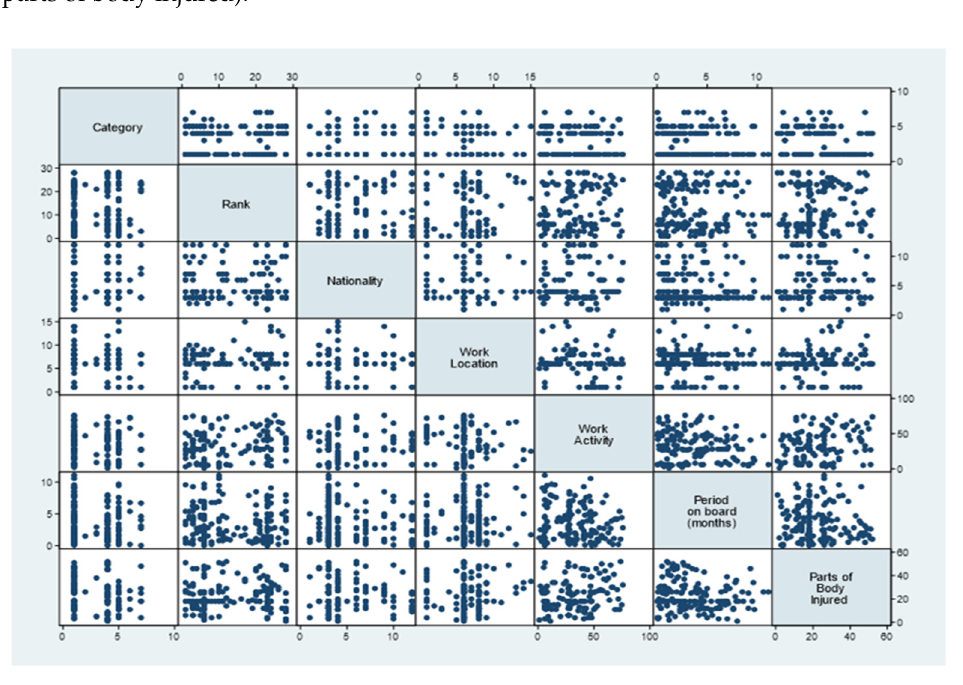
Figure 1. Panel correlation of specific variables. Source: Own data process in Stata.